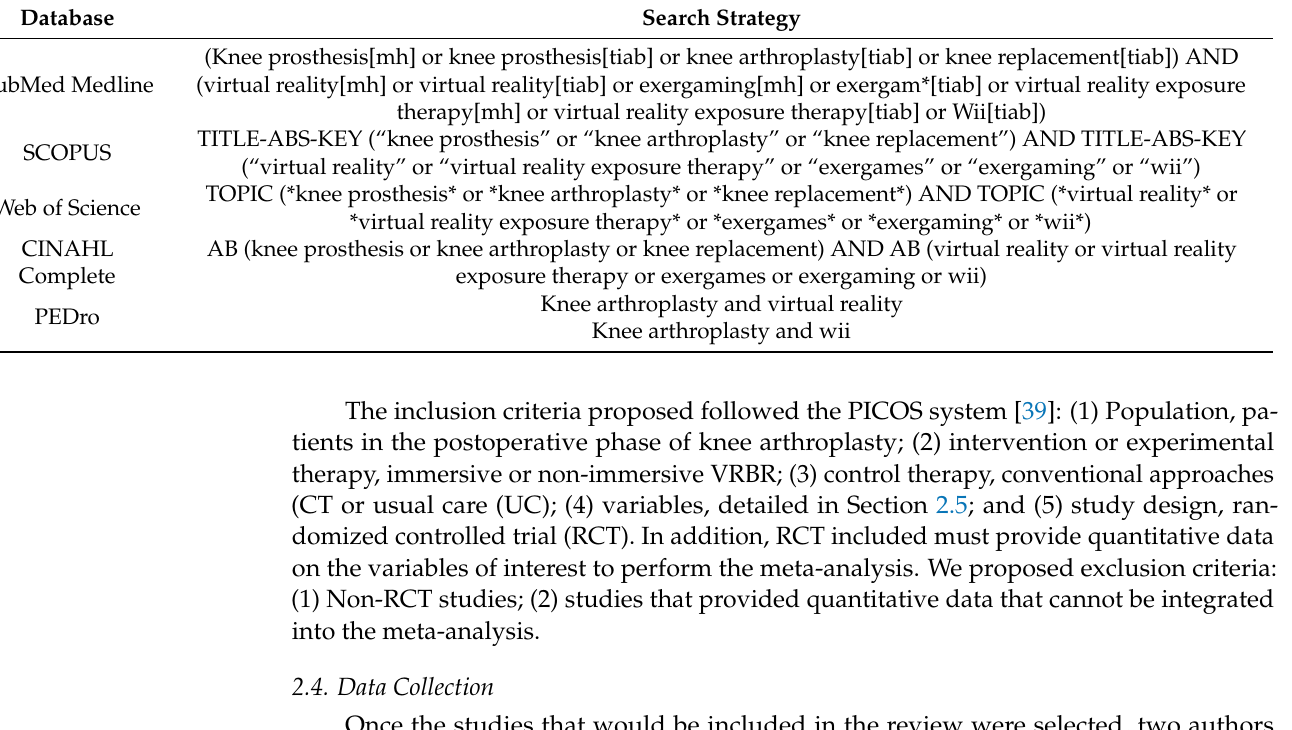
Table 1. Literature searches in